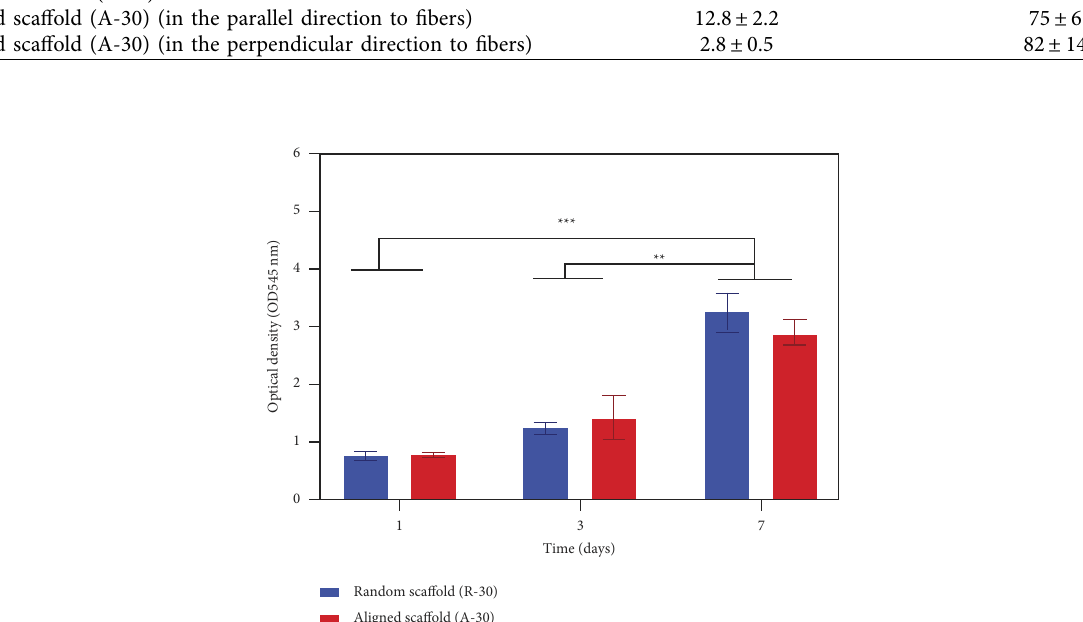
Figure 7: MTT results of the ARPE cells cultured on the electrospun scafolds after 1, 3, and 7days of cell seeding.